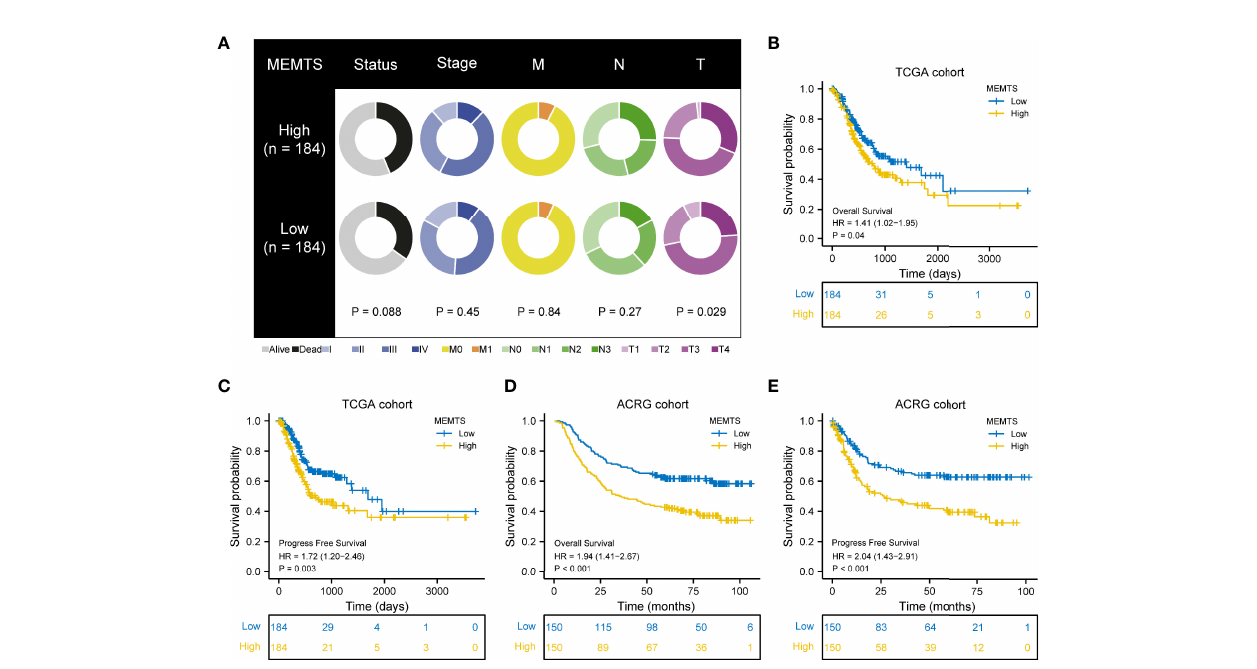
FIGURE 3 | Correlation between MEMTS subtypes and clinicopathological features and prognosis in TCGA and ACRG cohort. (A) Different clinicopathological features of high and low MEMTS subtypes in TCGA cohort. (B – E) Kaplan – Meier survival plots showing the differences of overall survival and progression-free survival between high and low